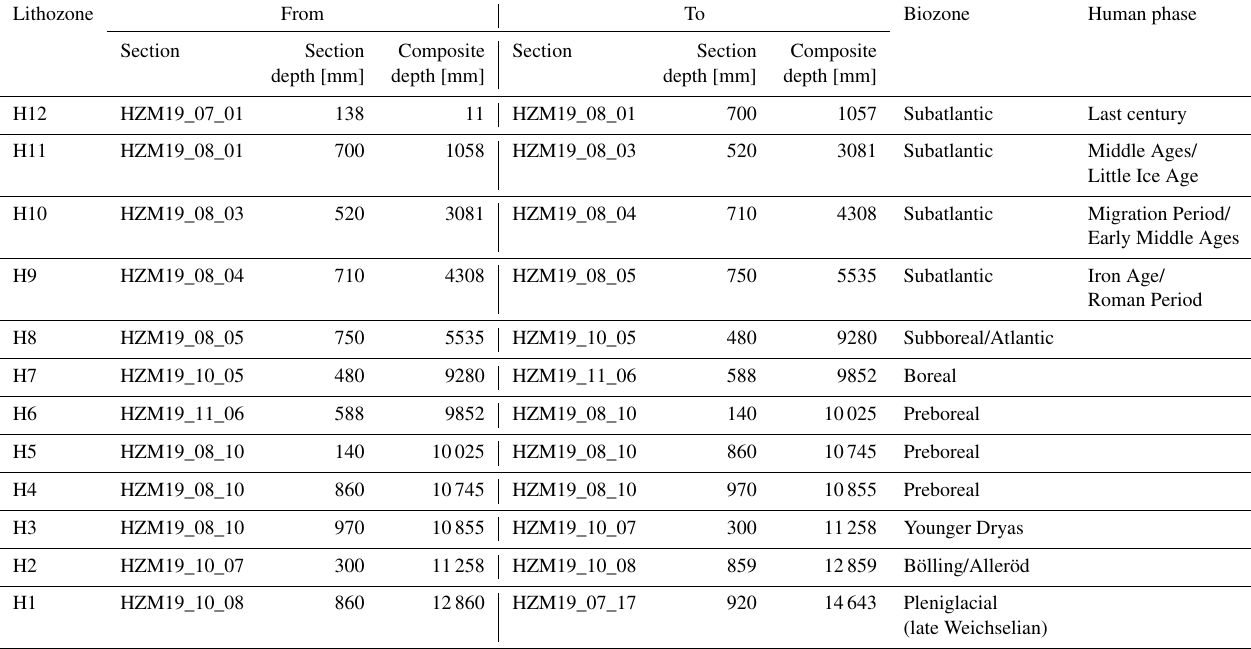
Table A1. Core section and composite depths of lithozones H1 to H12 for HZM19. Lithozone